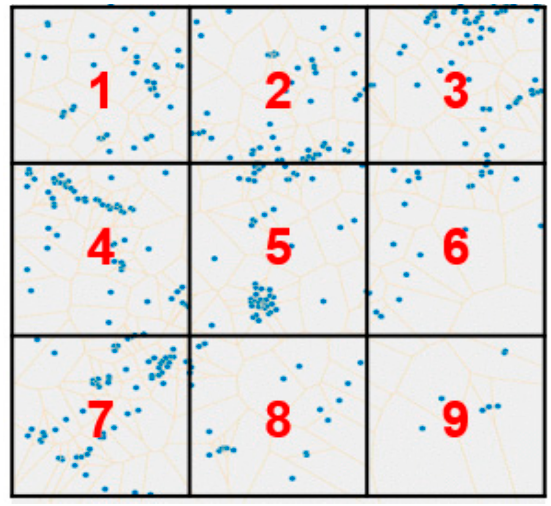
Figure 11. Subsection of the Voronoi diagram.